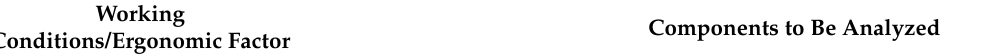
Table 1. Ergonomic